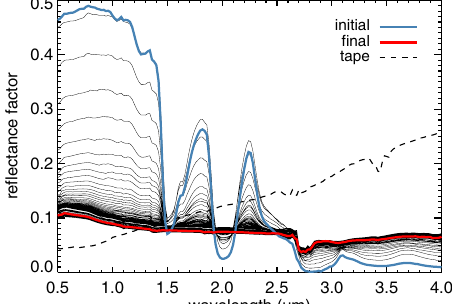
Fig. 4 Spectral changes during the Ceres analogue sublimation experiment. Spectra of the ice sample under vacuum at 173 K were acquired in hourly intervals at the standard geometry of ( ι , ϵ , α ) = (0°, 30°, 30°). The fi rst and last spectrum in the series are highlighted in blue and red, respectively. The initial spectrum is that recorded at the start of the experiment under medium vacuum. The fi nal spectrum is the last one of the series recorded after 133 h under high vacuum. The dashed line is the spectrum of the empty container, which is coated with black aluminium